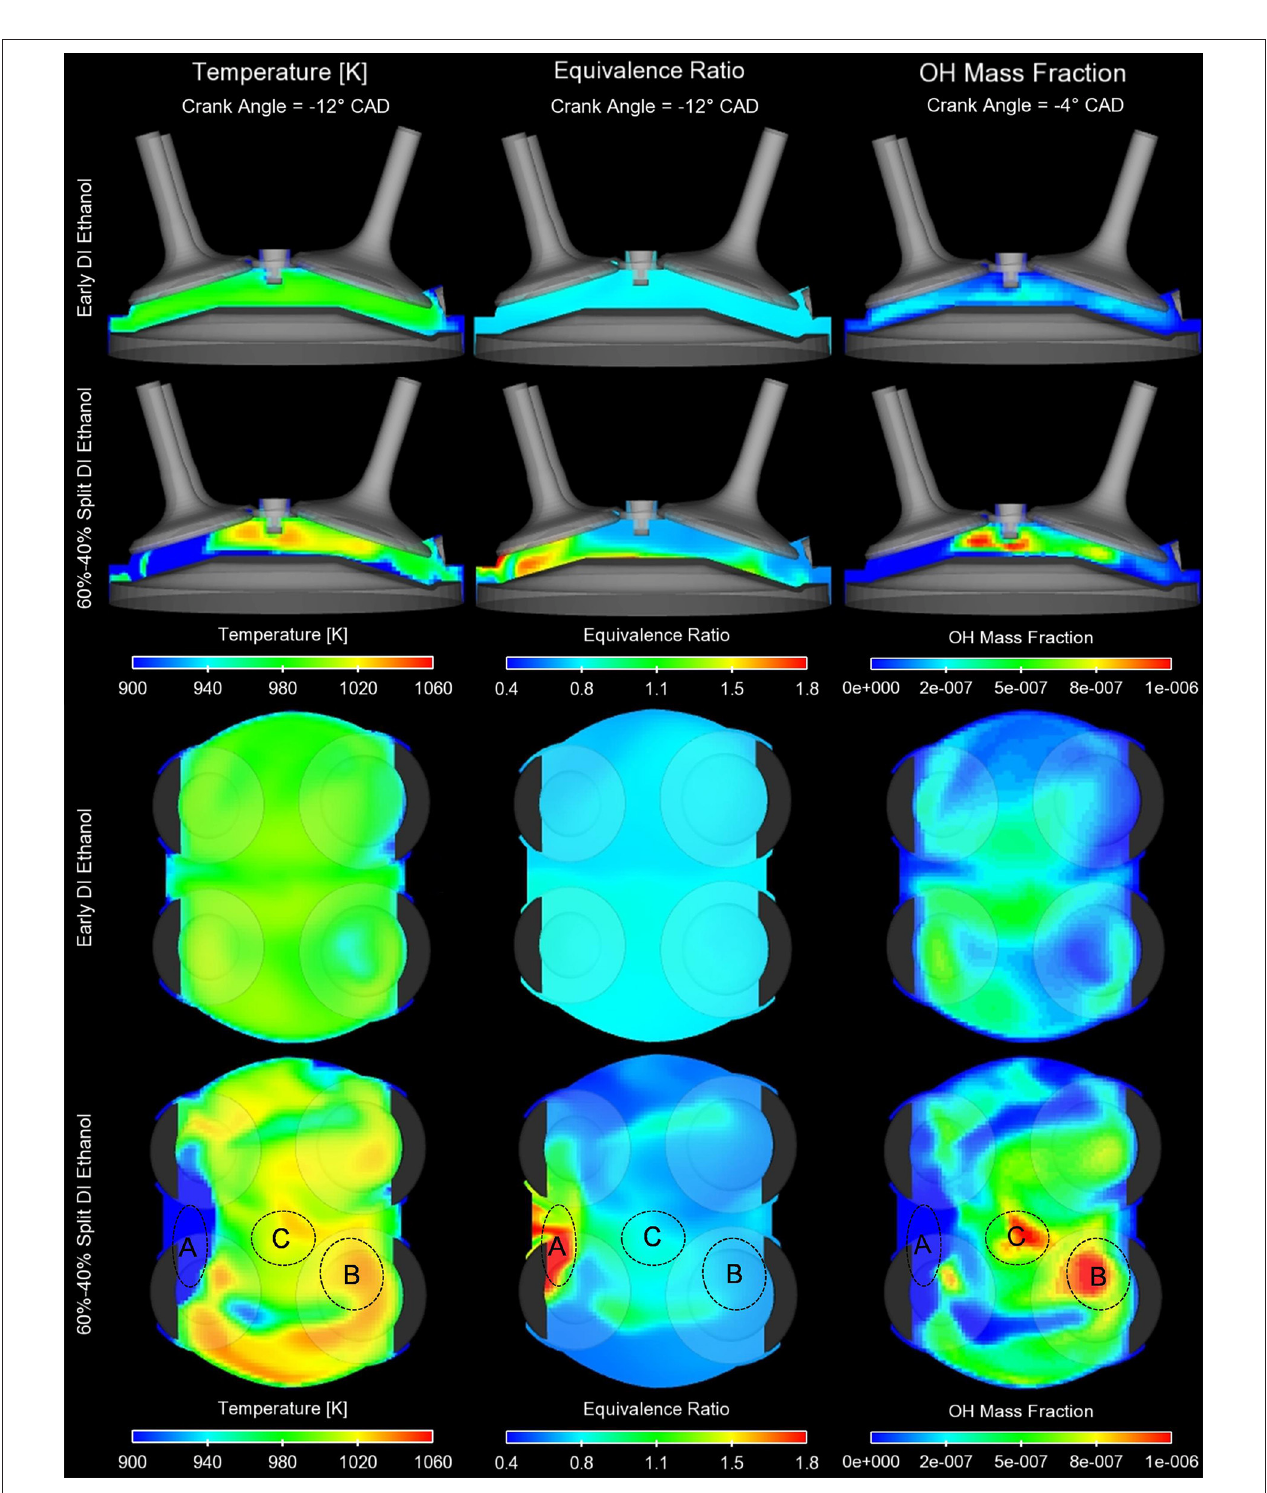
FIGURE 7 | Ethanol: Vertical and horizontal cut-planes of temperature, equivalence ratio, and OH mass fraction distributions for the early DI case and the 60–40% split DI case. The temperature, equivalence ratio, and OH mass fraction distributions are fairly uniform for early DI case; while for the 60–40% DI case, these distributions are stratified due to the second direct injection. Also, it is clear that the OH mass fraction distribution is governed by the temperature distribution and not the equivalence ratio distribution.